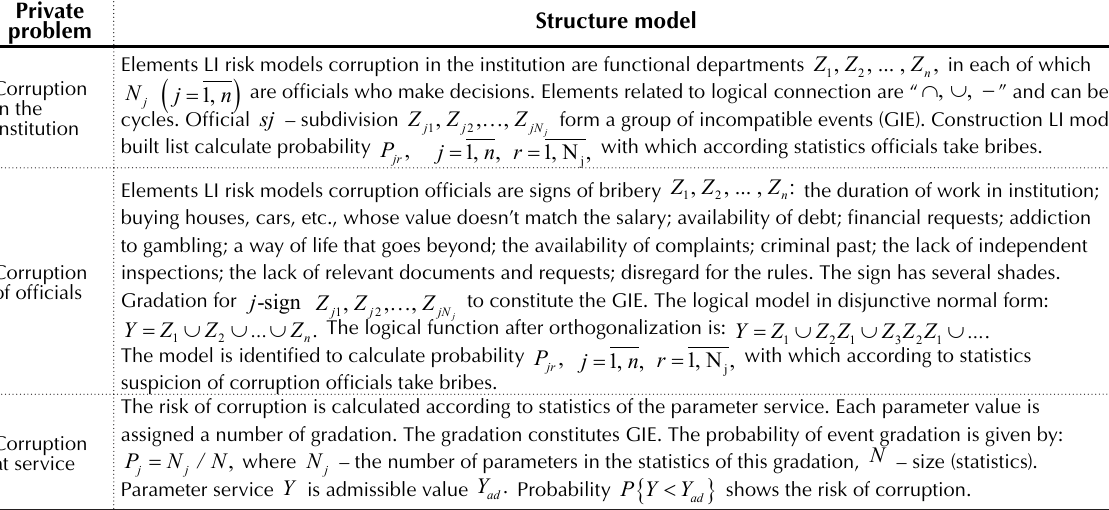
Table 3. LI models of risk corruption for solving particular problems Source: Compiled by the authors based on the materials by Chkhartishvili